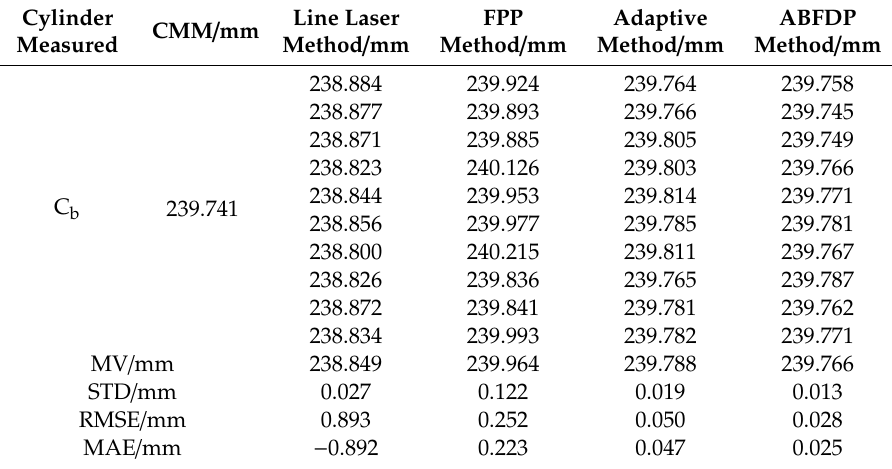
Table 3. Diameter measurement results of C b with di ff erent methods.